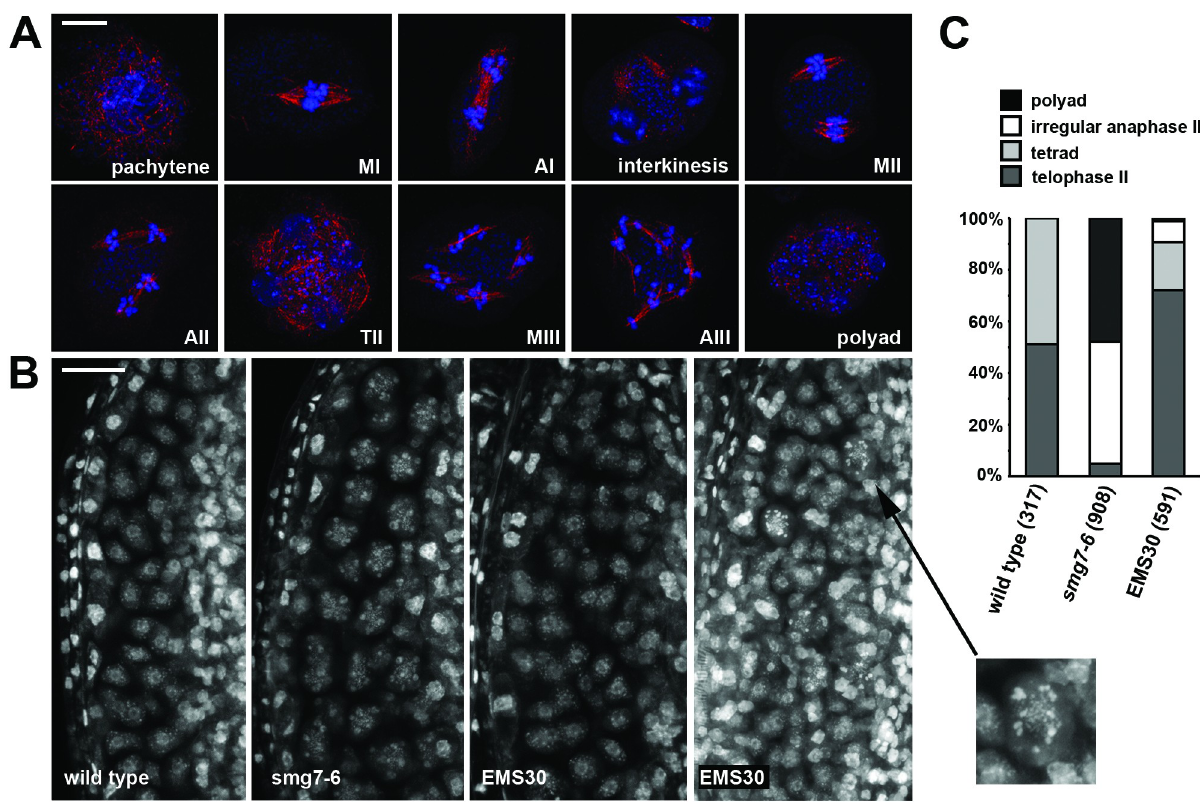
Fig 5. Meiotic progression in the EMS30 line. (A) Immunocytological analysis of EMS30 PMCs with spindles visualized with anti- α -tubulin antibody (red). DNA is counterstained with DAPI (blue). MI, MII, MIII—metaphase I, II, III; AI, AII, AIII—anaphase I,II, III; TII—telophase II. Scale bar represents 5 μ m. (B) Anther loculi stained with DAPI. Wild type and smg7-6 loculi contain tetrads and polyads, respectively. EMS30 plants contain tetrads (middle panel) and a mixture of polyads, tetrads, and AIII in their loculi (right panel). The inset shows a detail of a PMC in the MIII/AIII stage. Scale bar represents 20 μ m. (C) Quantification of PMCs in late stages of meiosis. Number of PMCs analyzed for each genotype is indicated in